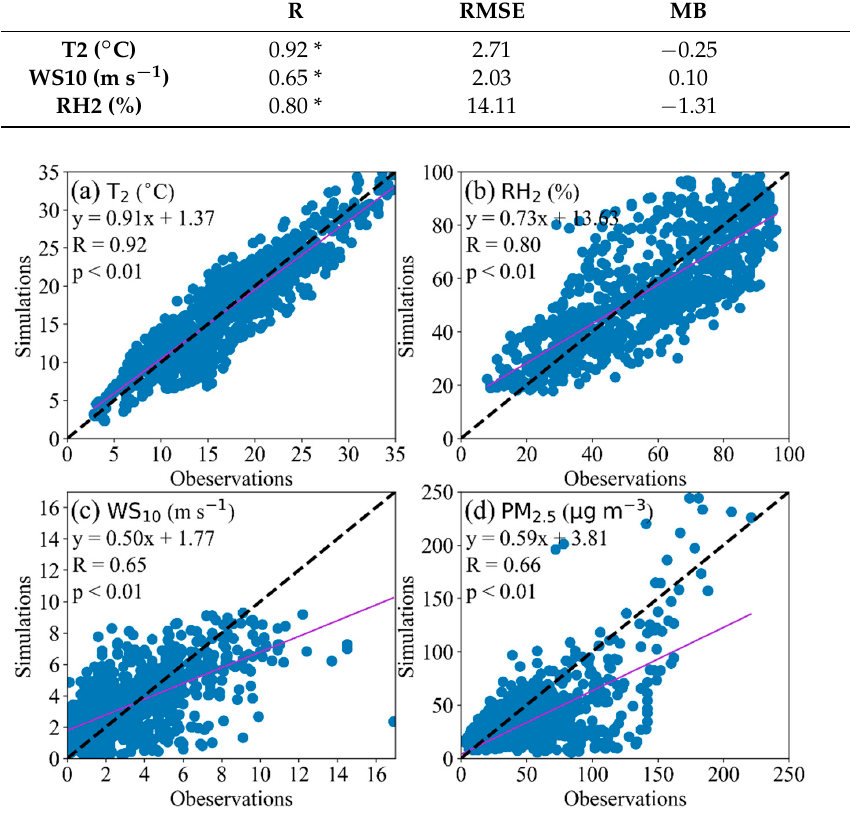
Figure 2. Scatter plots between observations and simulations of hourly meteorological parameters and PM 2.5 at 11 typical sites during 24–26 March 2017 (blue dots) with liner fitting lines (purple solid lines) passing 99% significance level and 1:1 line (black dash lines) between observations and simu- lations. Table 3. Statistical metrics between observed and simulated meteorological parameters averaged over 11 typical sites during 24–26 March 2017. The “*” indicates R passed the 99.9% confidence level.